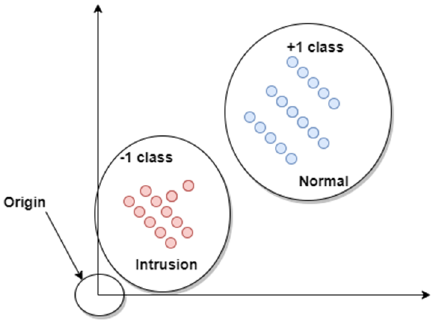
Figure 3. One-class SVM (Support Vector Machine) classifier based on relaxation parameters.